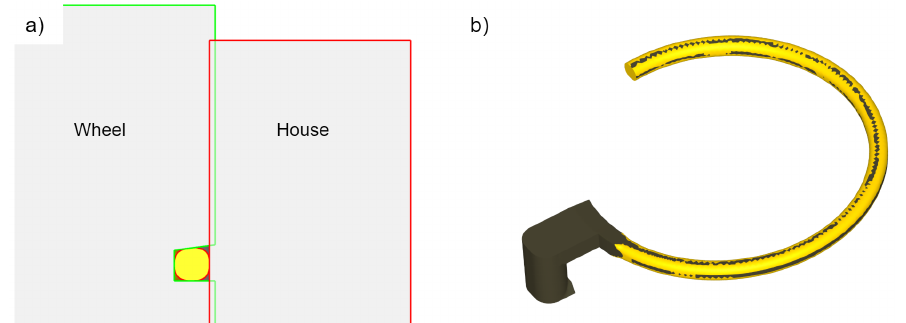
Figure 5. The initial contact between the feedstock material and the tooling for model 1. ( a ) section through the wheel and housing; ( b ) the feedstock with indication of contact points.